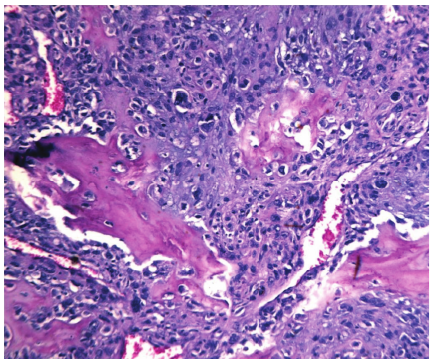
Figure 4: Osteosarcoma cells: mesenchymal elements of medium or large size with hyperchromatic, pleomorphic, and multinucleated nuclei arranged around an osteoid matrix (hematoxylin and eosin,